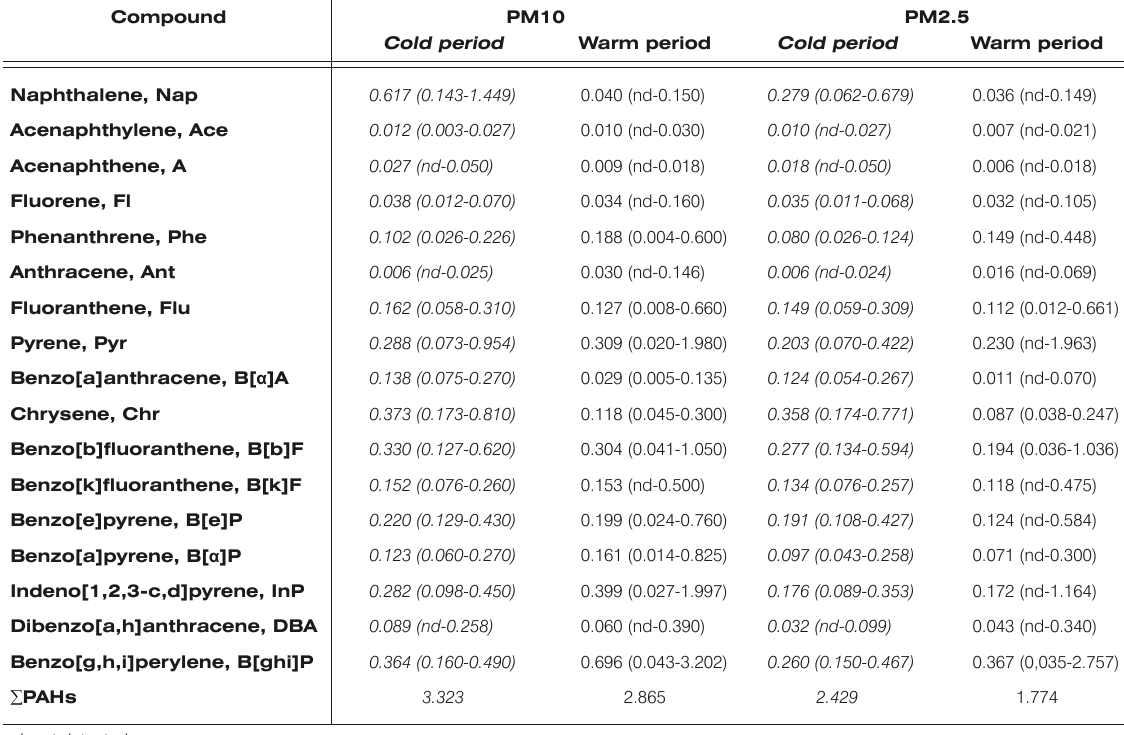
Table 2. Mean (min-max) particulate PAH concentrations at Kozani city (ng m -3 ).